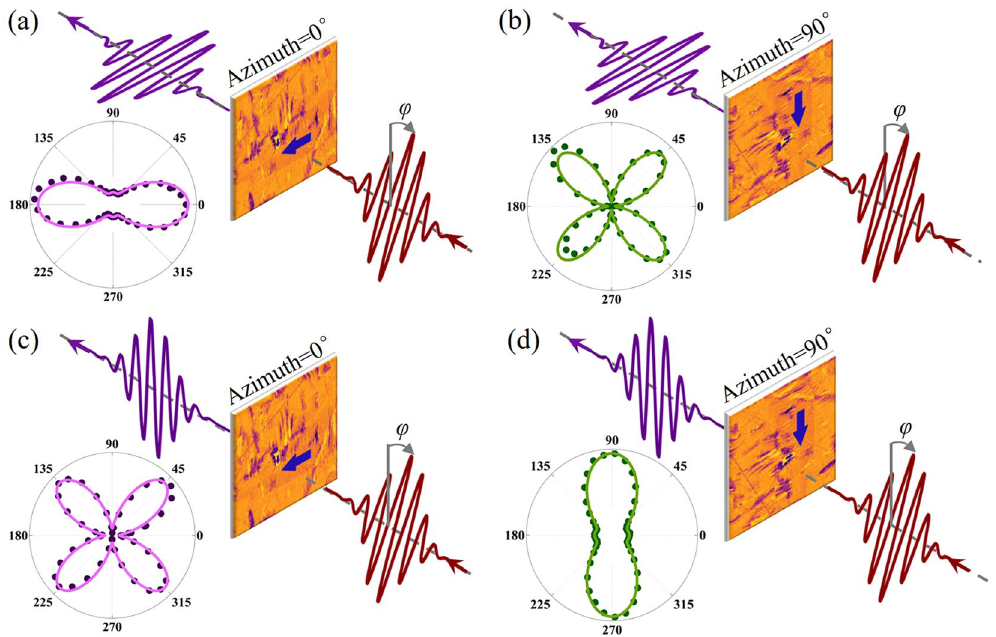
Figure 4. Visual correlation between SHG anisotropy patterns and the dominated polarization orientations (blue arrow) in perpendicular configuration at ( a ) azimuth = 0° and ( b ) 90° and in parallel configuration at ( c ) azimuth = 0° and ( b ) 90°. The polarization of optical fields after analyzer and 1/2 wave plate are colored in purple and red respectively. In four polar plots, the colored circles show the experimental data, while the simulation results are plotted with solid lines. ϕ = α